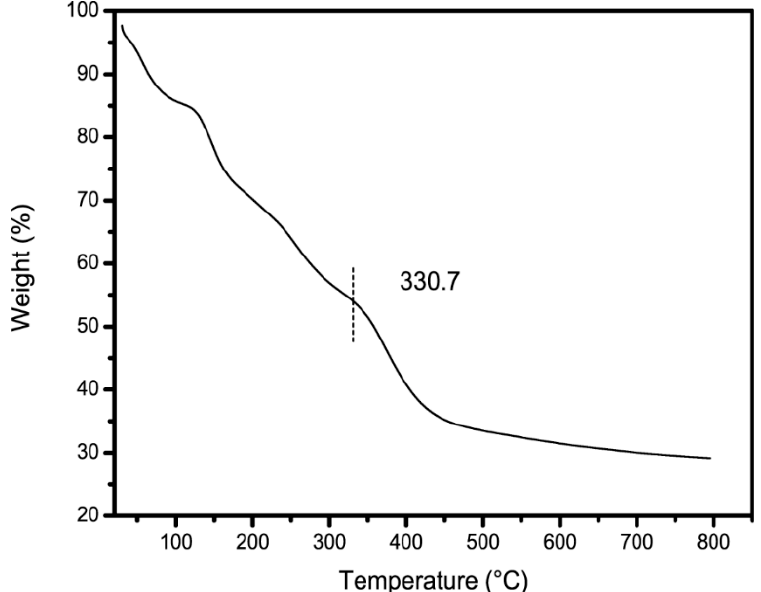
Figure 6. TGA of CAG-GO20%.